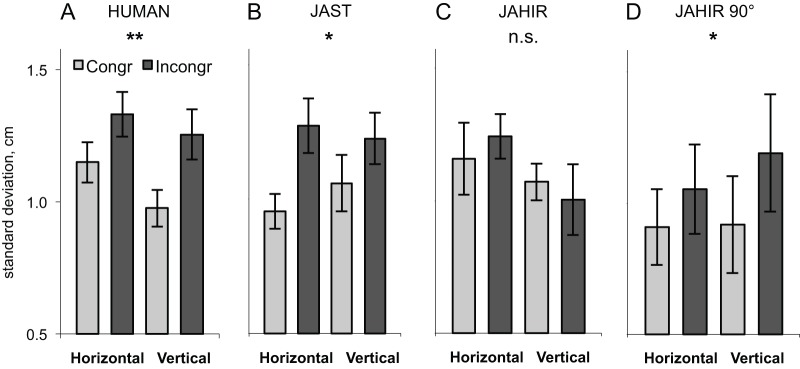
Results using the standard analysis.Standard deviation (SD) of movement from the instructed movement plane during observation of incongruent and congruent movements of the human agent (A), humanoid robot JAST (B), industrial robot JAHIR (C) and rotated industrial robot JAHIR90° (D). Data from all subjects (including [13]), i.e., each graph represents a different number of subjects (see text). Error bars represent standard error of the mean. Stars denote significance (** p<0.01; * p<0.05).